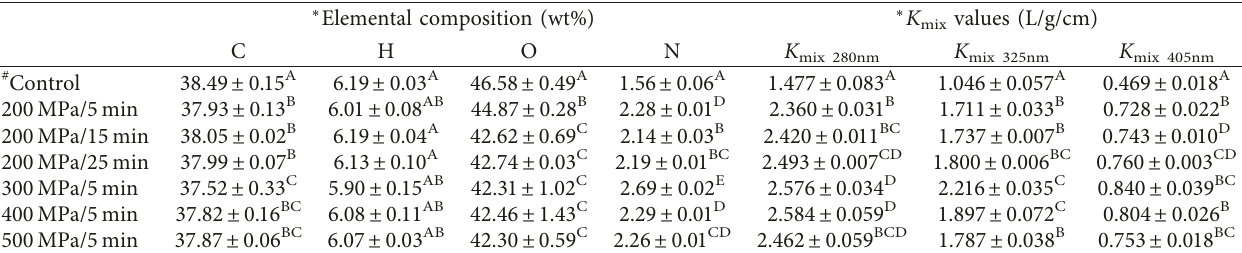
Figure 2: Total phenolic and total flavonoid contents in melanoidins after different HHP treatments. Different uppercase letters in the same line indicate significant differences at the P < 0 . 05 level. Table 1: Elemental composition and K mix values of black garlic-extracted melanoidins under different high hydrostatic pressure-processing conditions.